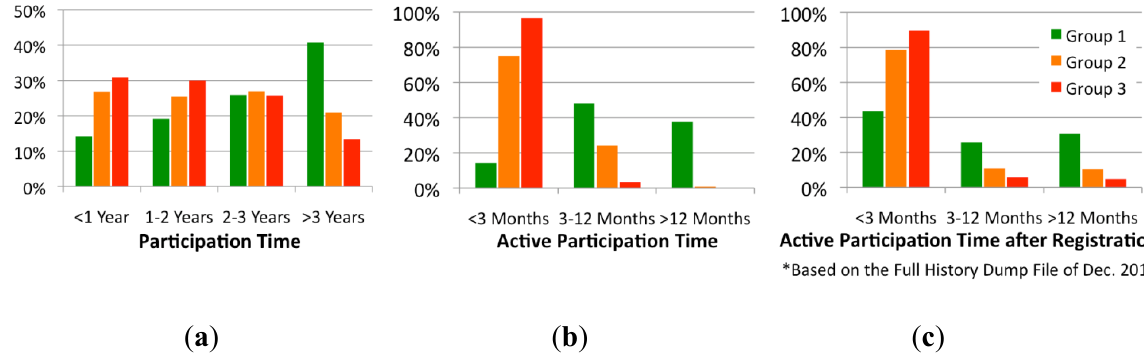
Figure 15. ( a ) Participation, ( b ) active participation and ( c ) active participation after project